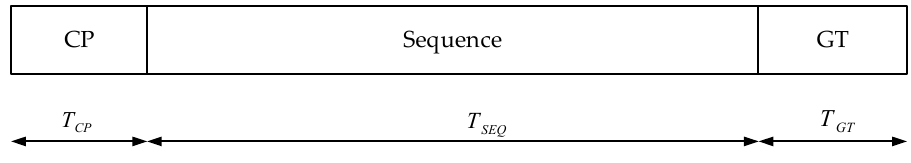
Figure 3. PRACH channel format.